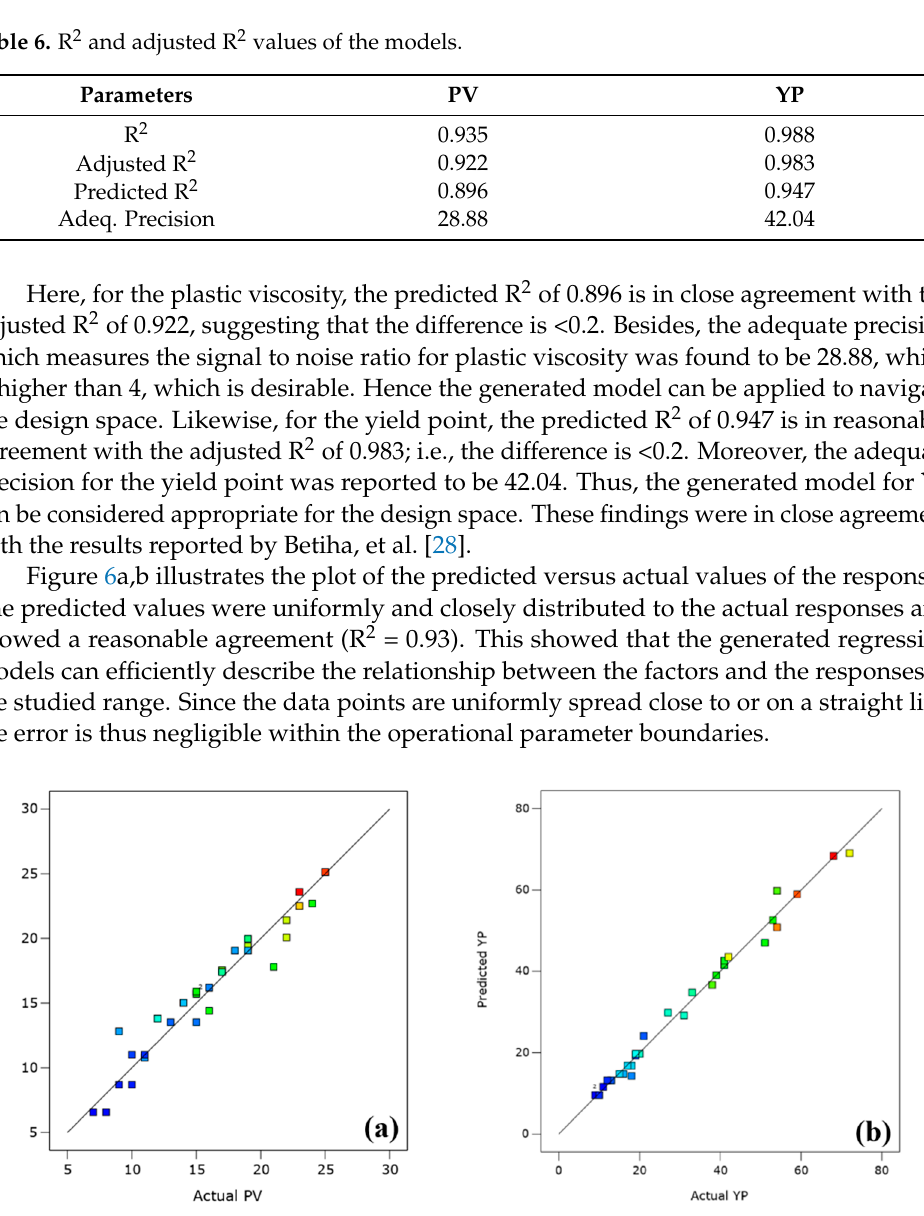
Figure 6. Predicted versus actual plots of ( a ) PV and ( b ) YP.